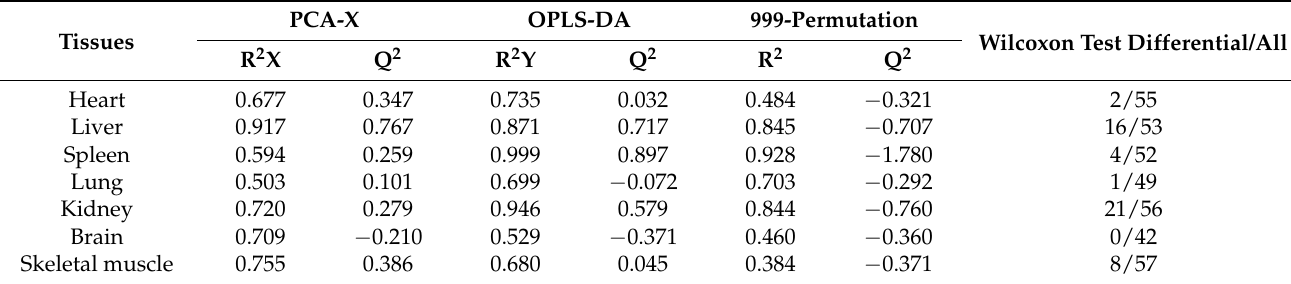
Table 2. The PCA-X mode, OPLS-DA mode, and 999-permutation were used for multivariate exploration of clusters and trends among two groups of male and female in seven